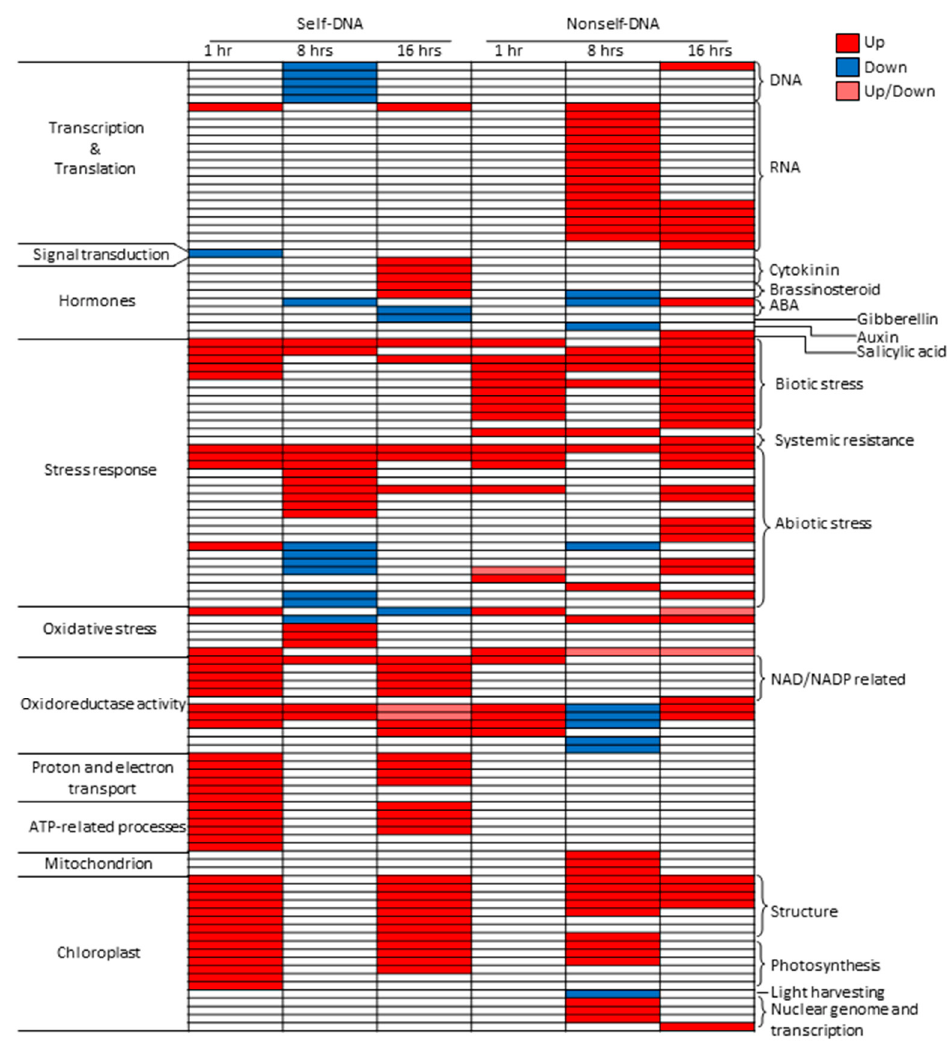
Figure 2. Summary of the GO enrichment analysis on filtered DEGs, with most enriched GOs (rows) grouped by functional process or cell compartment. The colour of each cell in the columns (indicating treatment type and stage) shows the pattern of expression of the enriching genes (full red: upregulated DEGs; blue: downregulated; light red: both up- and downregulated, with enrichment in upregulated DEGs showing lower p-value compared to the downregulated ones). In white, absence of enrichment is shown.